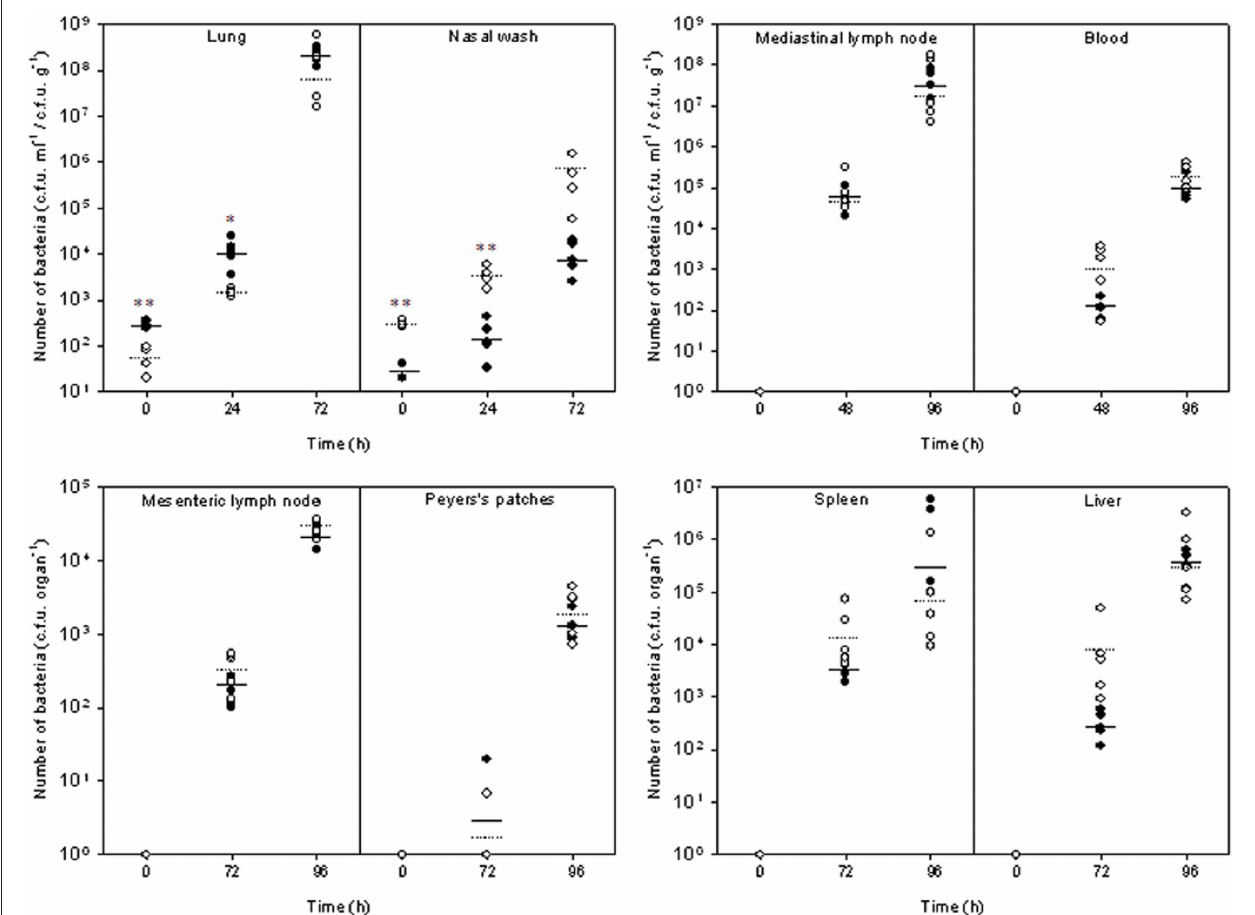
Mean values are indicated by the solid and dotted lines for the small particle and large particle infections respectively ( n = 5). Significant differences between the tissue loads are indicated by ∗ ( p < 0 . 05) and ∗∗ ( p < 0 . 01),